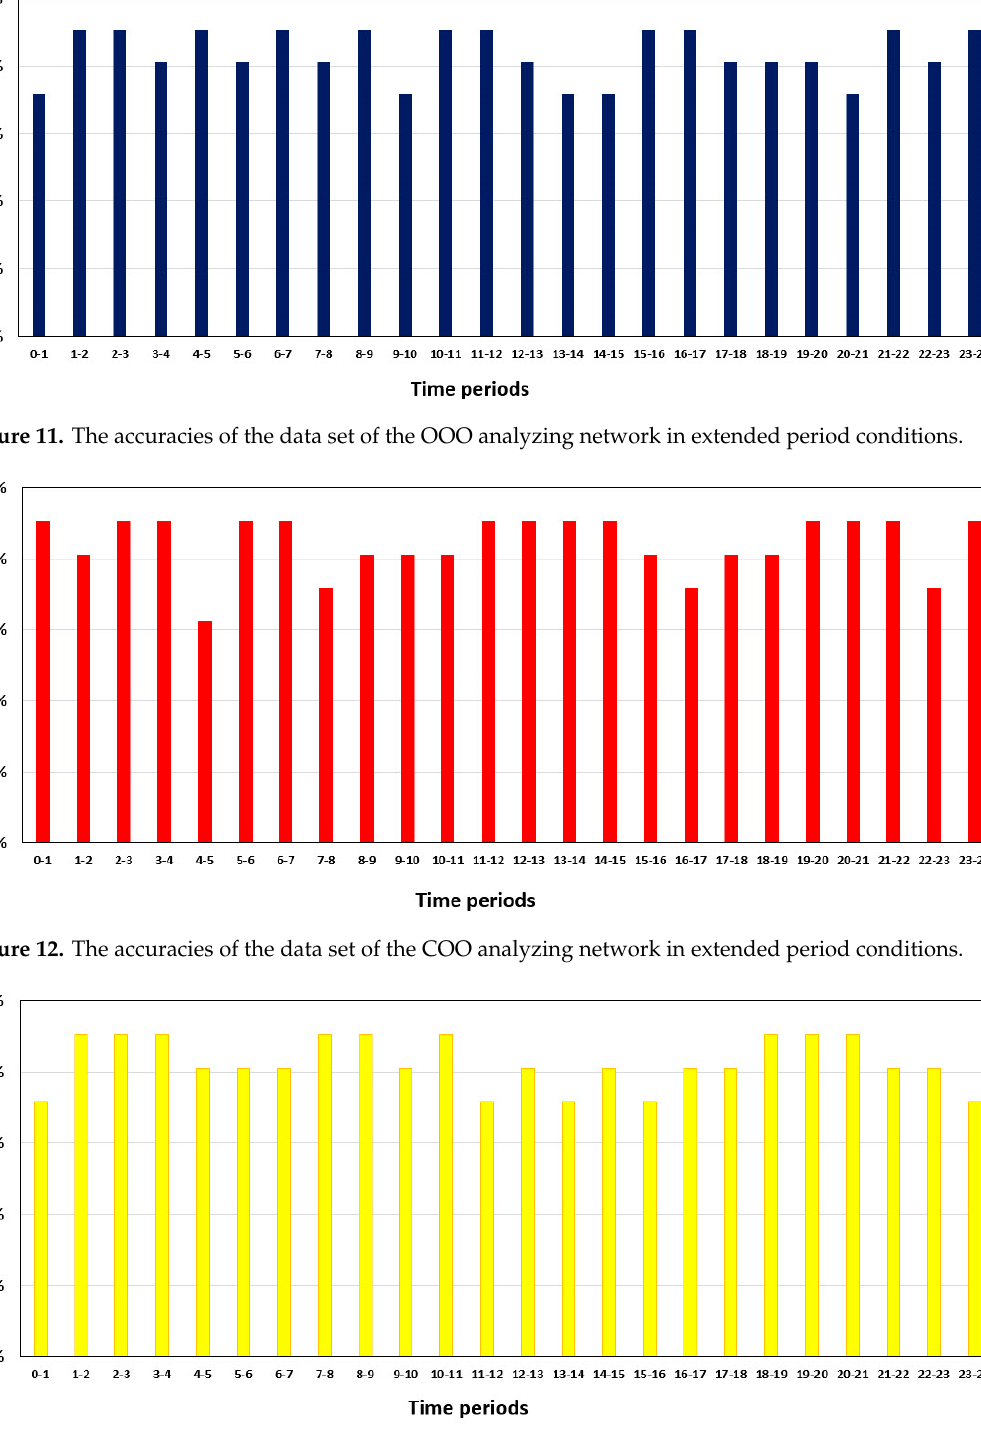
Figure 13. The accuracies of the data set of OCO analyzing network in extended period conditions.